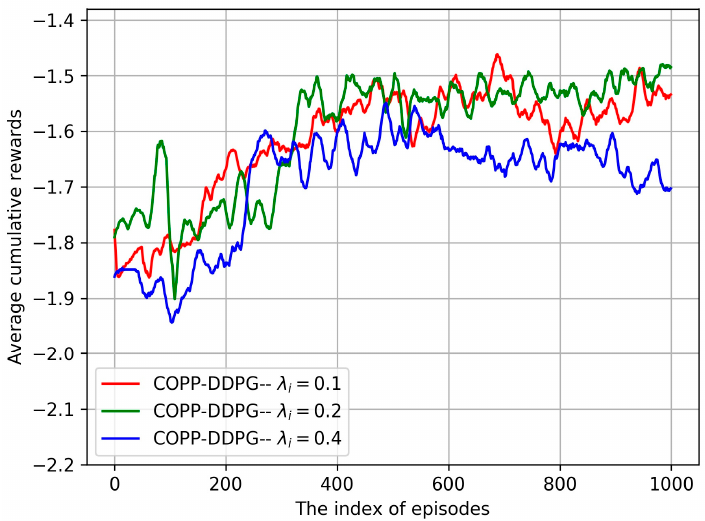
Figure 5. Convergence of COPP-DDPG with different partial offloading rates λ i .